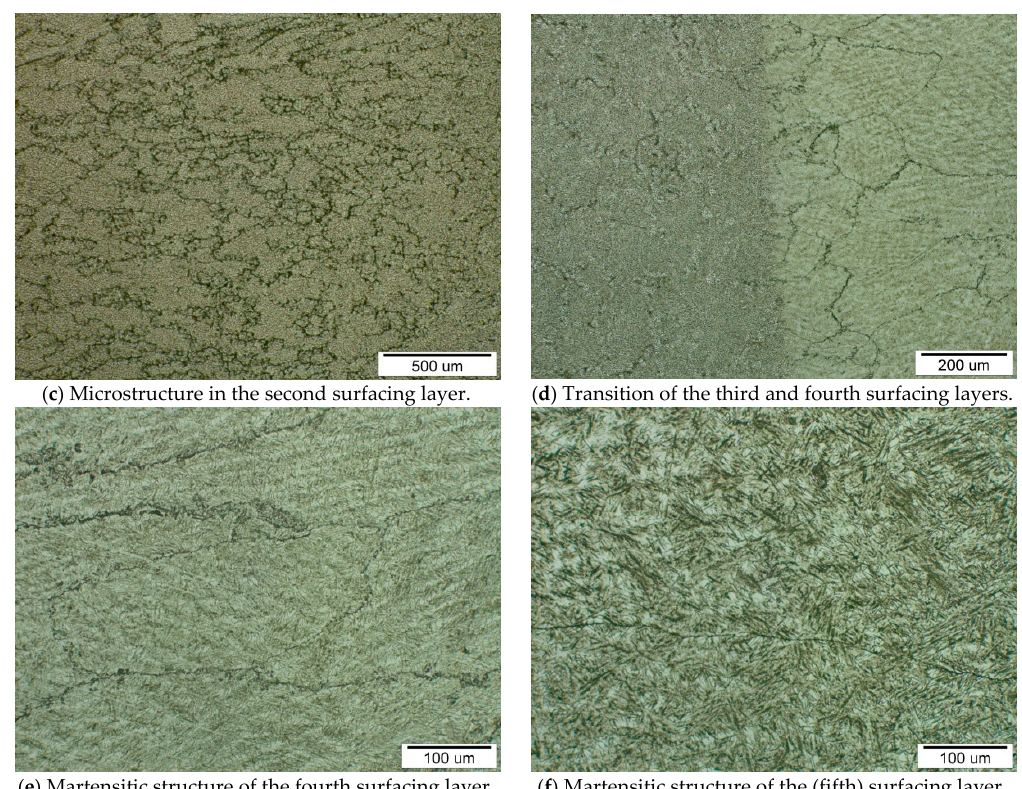
Figure 5. Microstructure of surfacing layer B4.